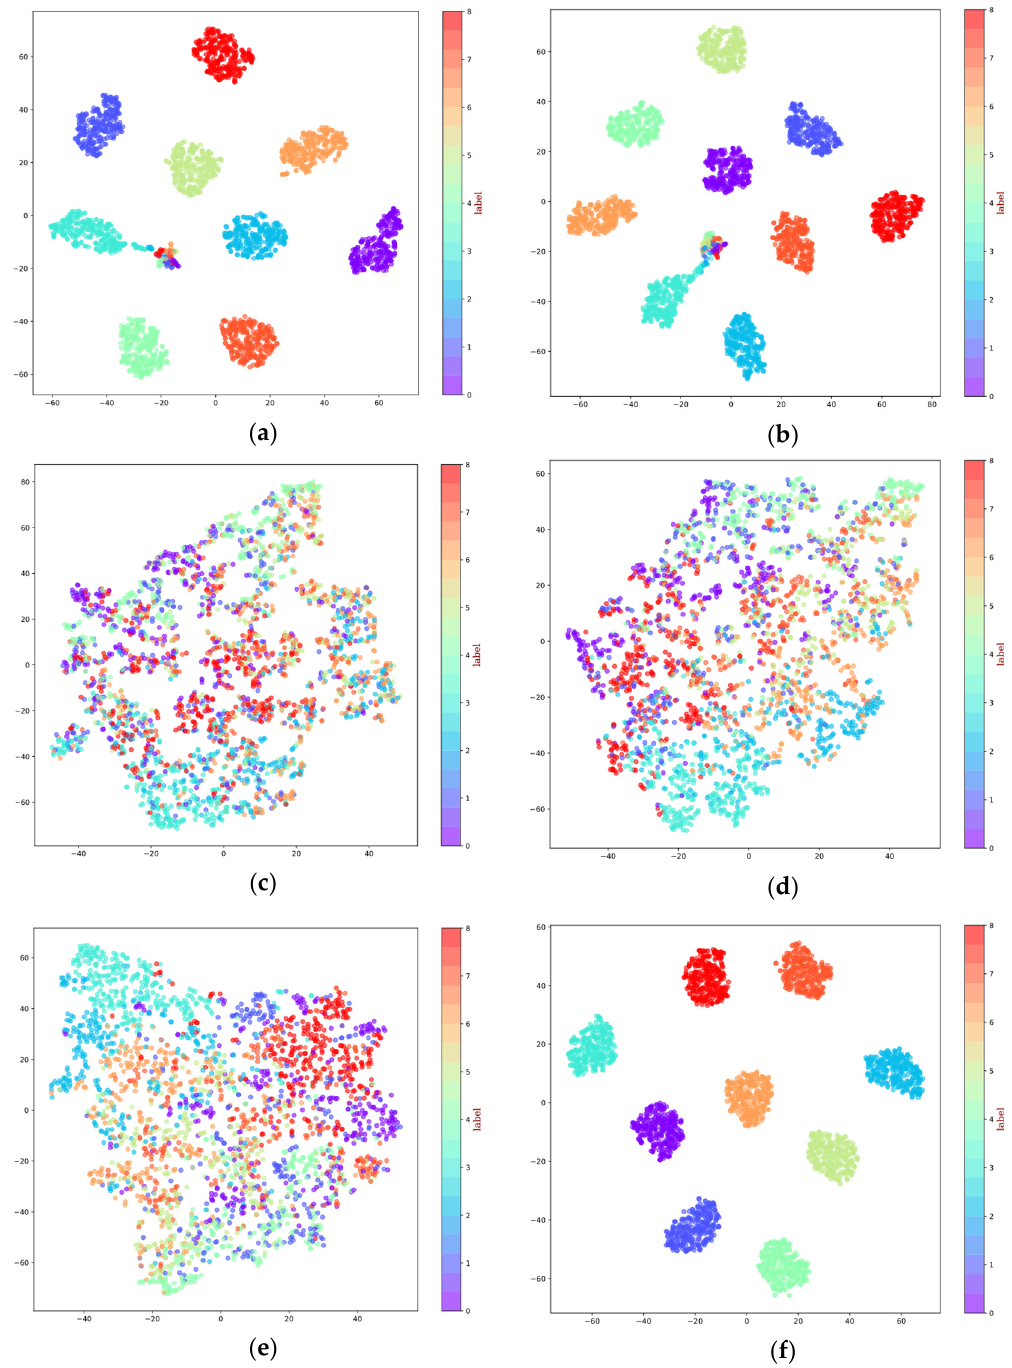
Figure 13. Visualization of features from the output layer for UoC dataset: ( a ) visualization results for AE, ( b ) visualization results for DAE, ( c ) visualization results for CNN, ( d ) visualization results for AlexNet, ( e ) visualization results for LSTM, ( f ) visualization results for proposed method.